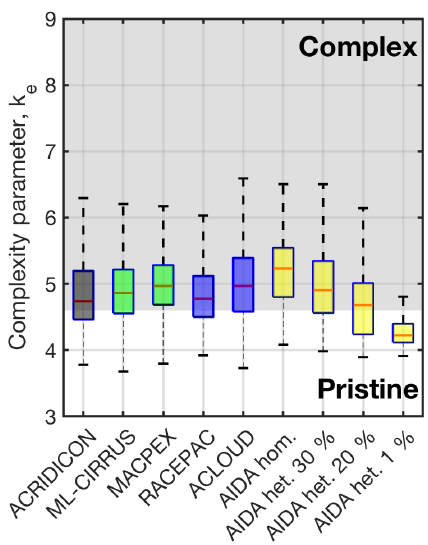
Figure 3. Statistical analysis of ice crystal complexity from all mea- sured ice particles in the aircraft campaigns and from four AIDA cloud chamber simulation experiments. The box edges represent the 25% and 75% quartiles and the dashed lines the 5% and 95% quartiles. The red lines represent the median values. The grey area indicates the range of the complexity parameter in which the ice crystals are characterized to be complex. The median complexity parameters were found to be 4.74 in ACRIDICON-CHUVA, 4.86 in ML-CIRRUS, 4.97 in MACPEX, 4.78 in RACEPAC and 4.97 in